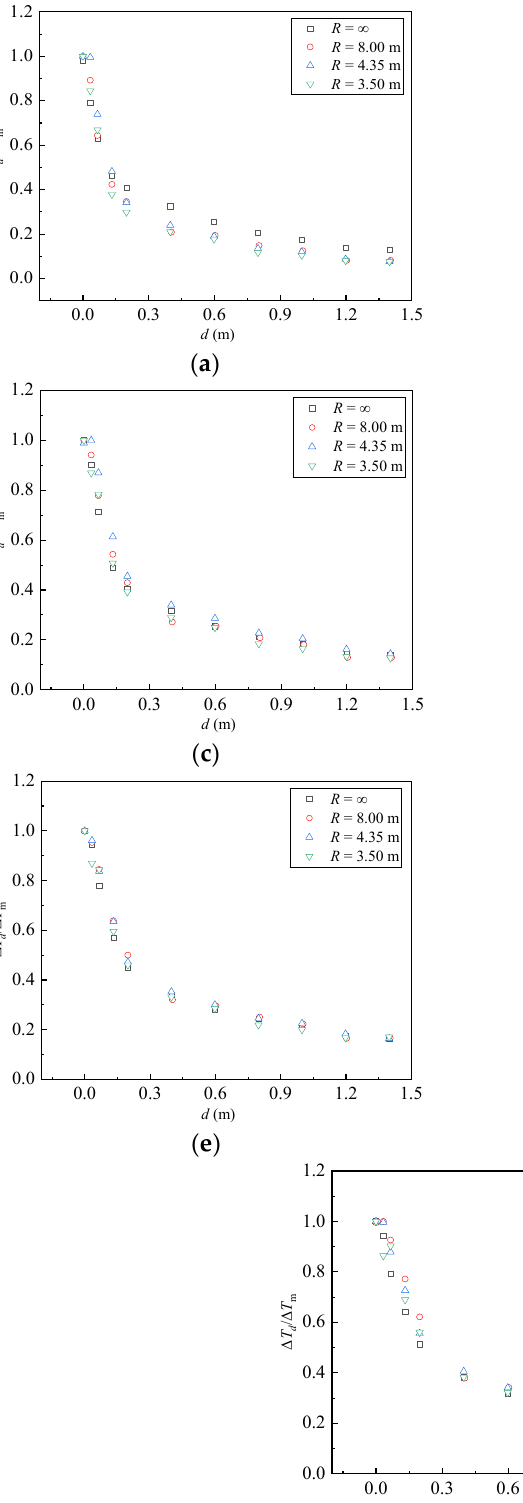
. Q = 0.76 kW; ( b ) . Q = 4.06